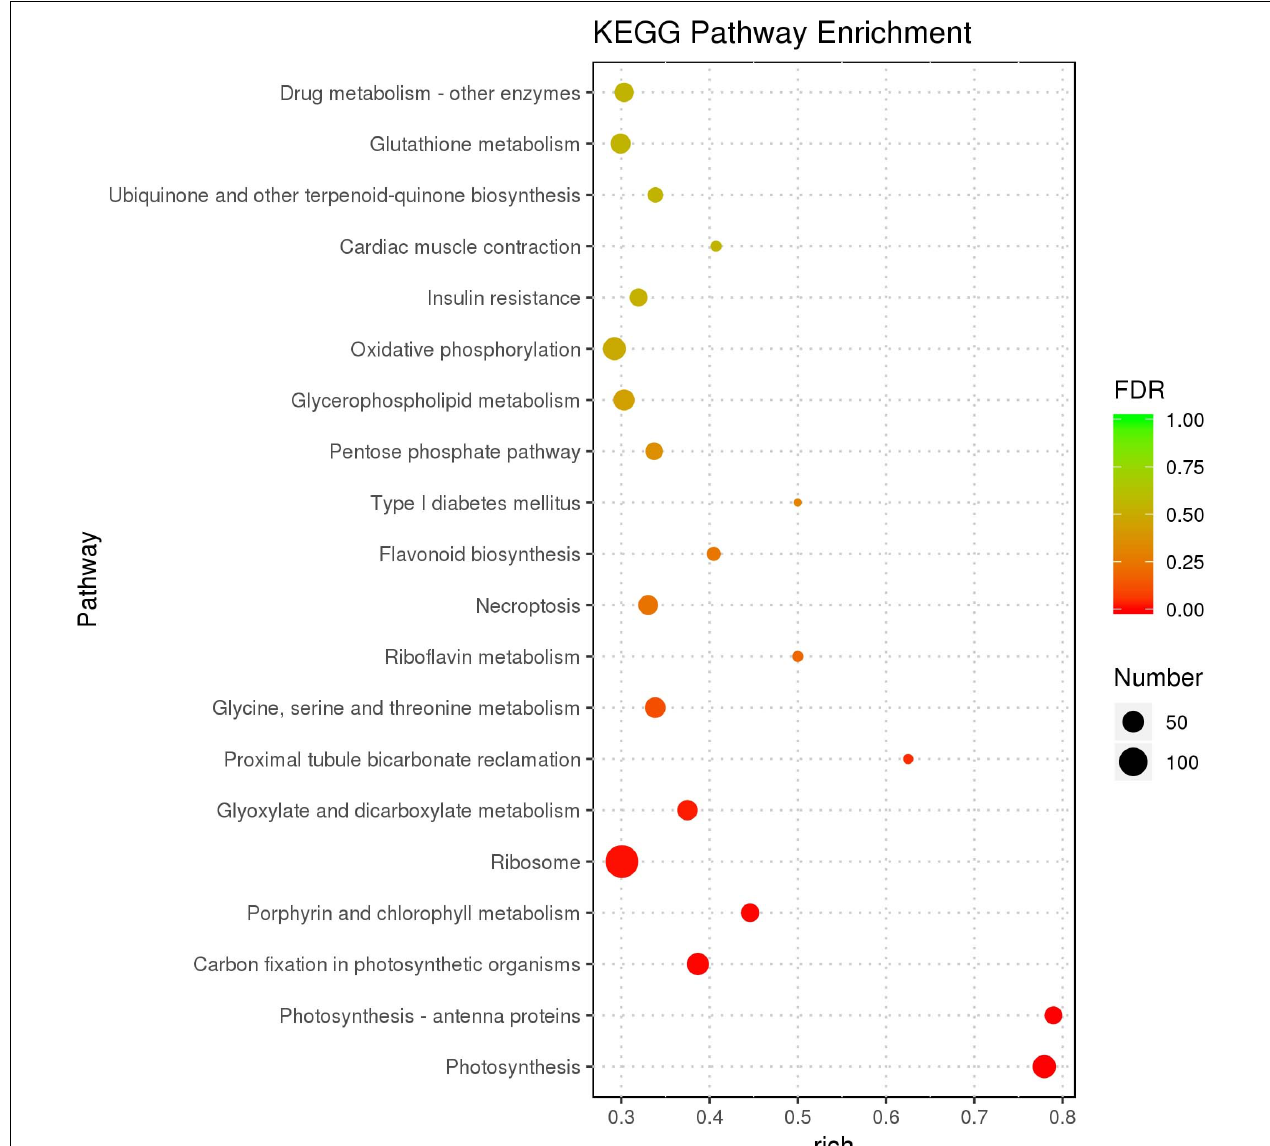
FIGURE 7 | Scatter plot of the KEGG pathway enrichment of DEGs. The size of the dots represents the number of genes, and the color of the dots represents the range of the